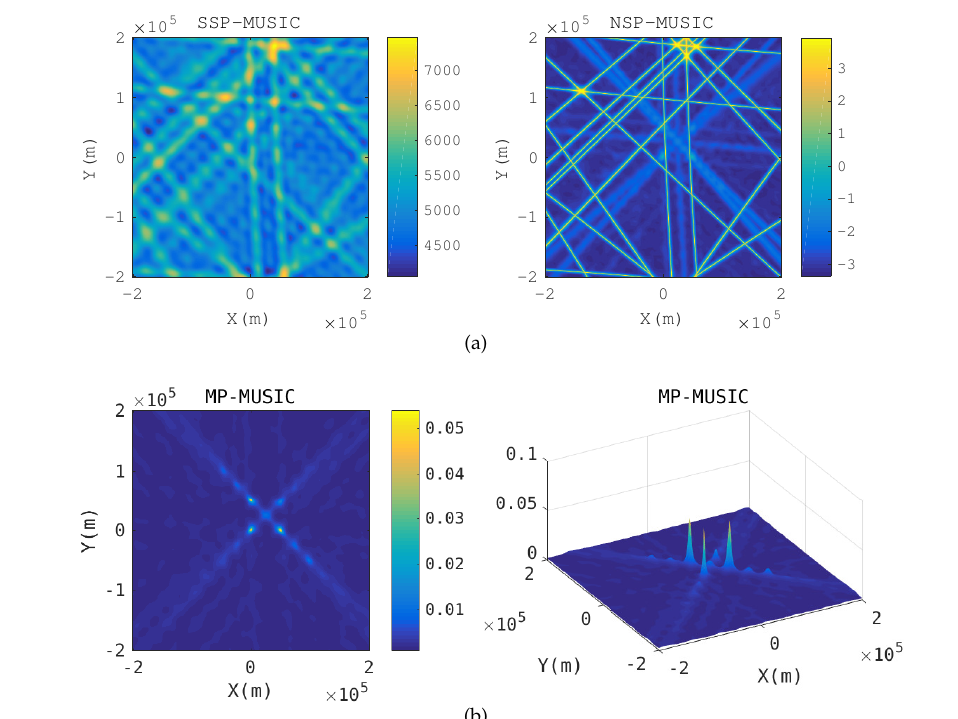
Figure 5. Spatial spectrum in baseband signal positioning. ( a ) Spatial spectrum of SSP-MUSIC and NSP-MUSIC ( b ) Spatial spectrum of Multi-path Propagation